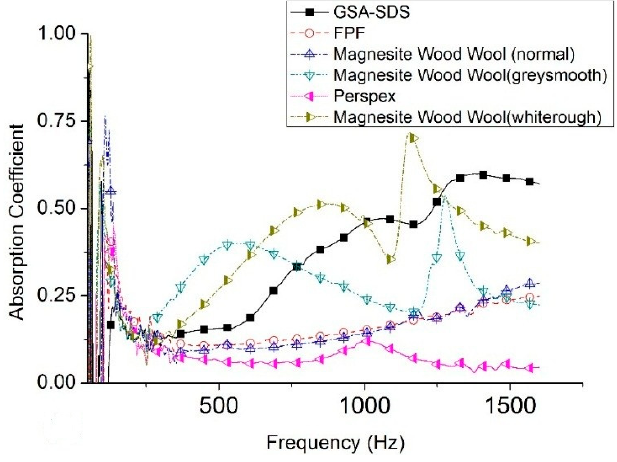
Figure 6. Comparison of absorption coefficients of GSA–SDS with other materials for 15 mm thickness at 50–1600